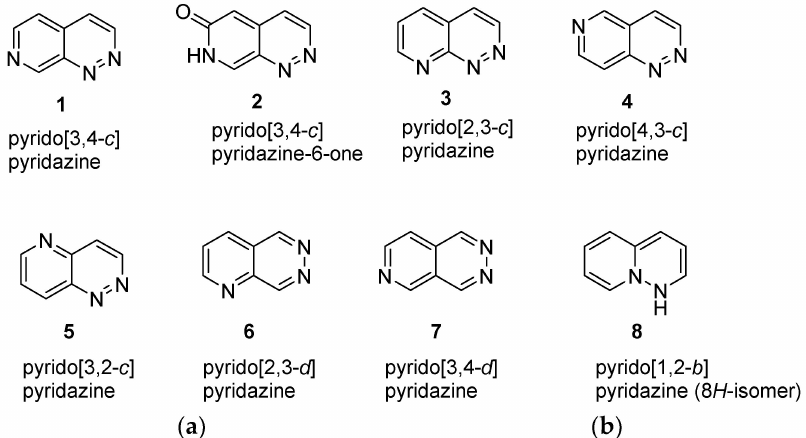
Figure 1. Pyrido[3,4- c ]pyridazine 1 , oxo derivative 2 and isomers 3 – 8